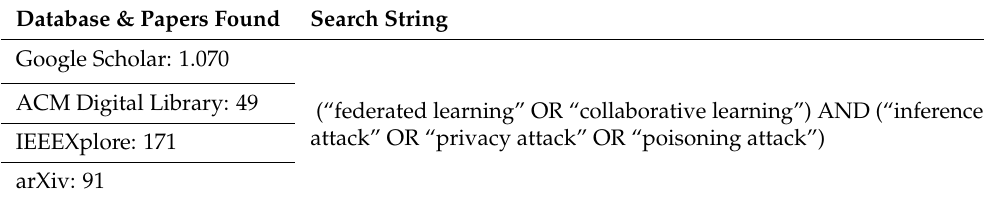
Table 1. Automatic search results and search strings.